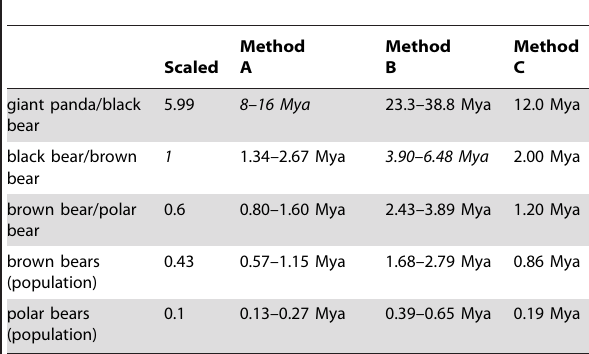
Table 1. Estimates of genomic